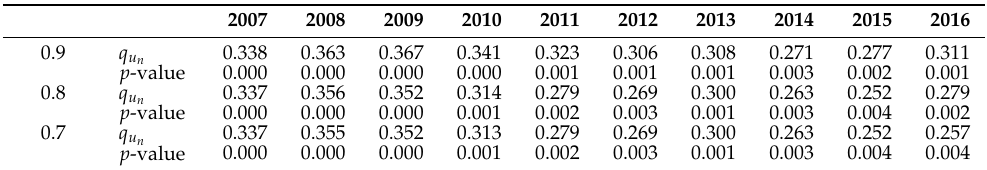
Table 11. The TQCC estimation between RCI (based on a 3-year rolling window) and regional carbon efficiency from 2007 to 2016 with uq = 0.9, 0.8 and 0.7.